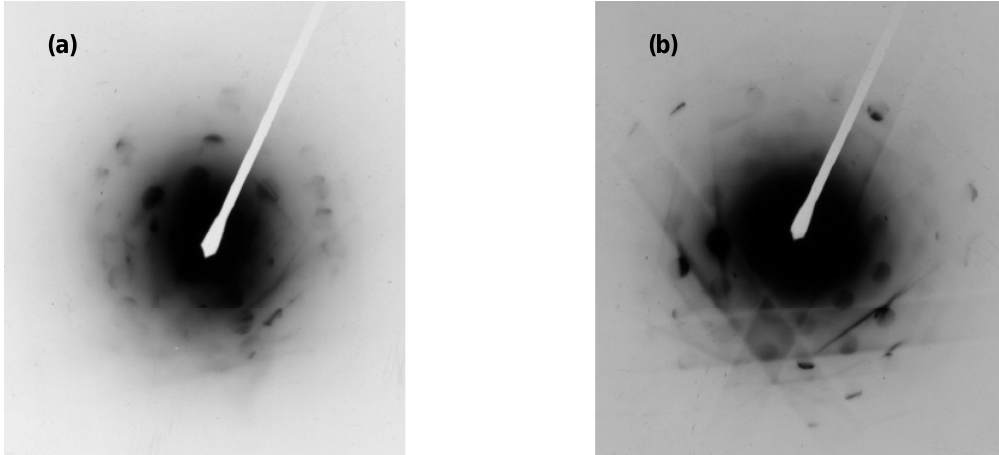
Fig. 2. Electron diffraction patterns of UFG aluminum alloy Al-4%Cu-0.5%Zr obtained by convergent beam electron diffraction in grain No. 1: (a) as-prepared state; (b) after the second